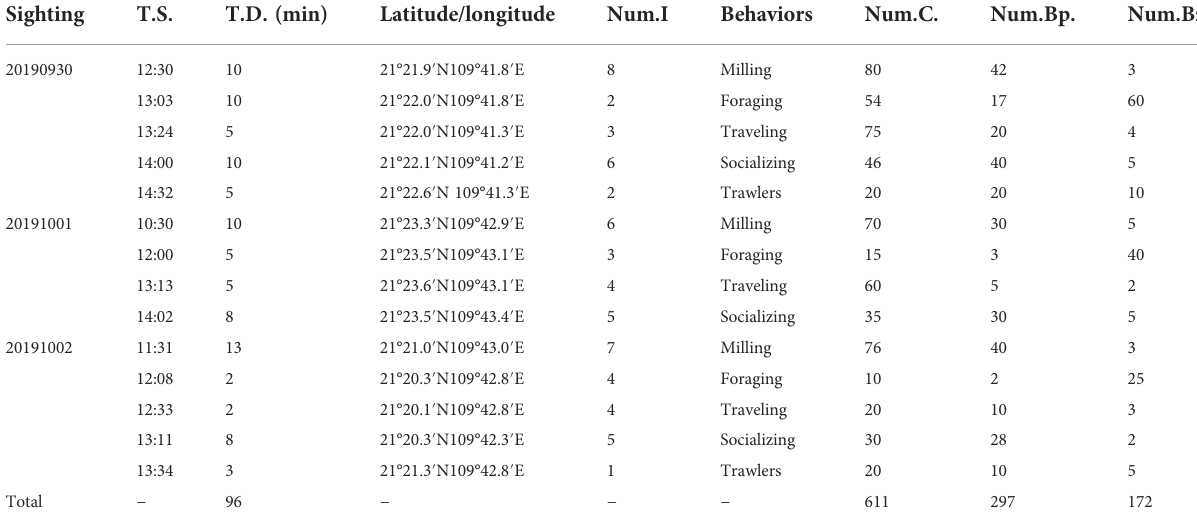
TABLE 4 Summary information and train types collected for Indo-Paci fi c humpback dolphins in Beibu Gulf, South China Sea. Sighting T.S.